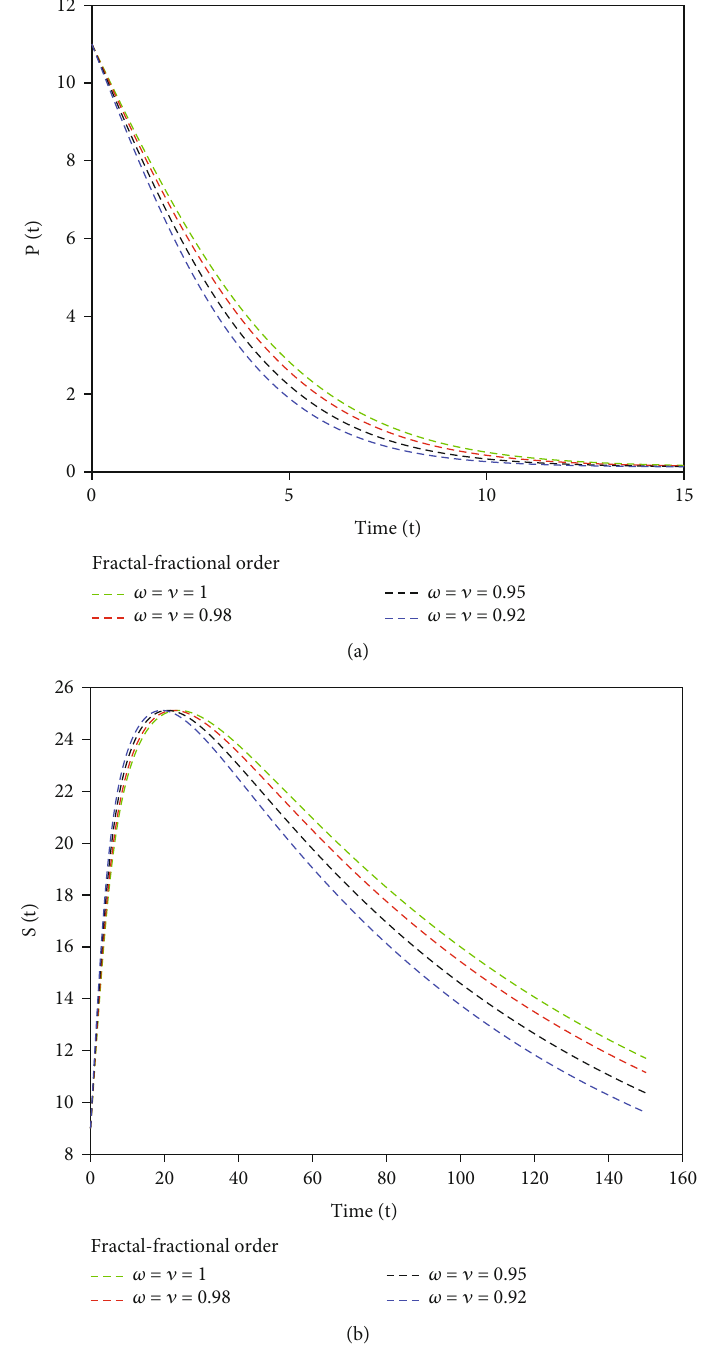
Figure 11: The simulation of the functions P ð t Þ and S ð t Þ during the time t for fractal dimensions and fractional orders ω = ν = 1,0 : 98,0 : 95,0 : 92